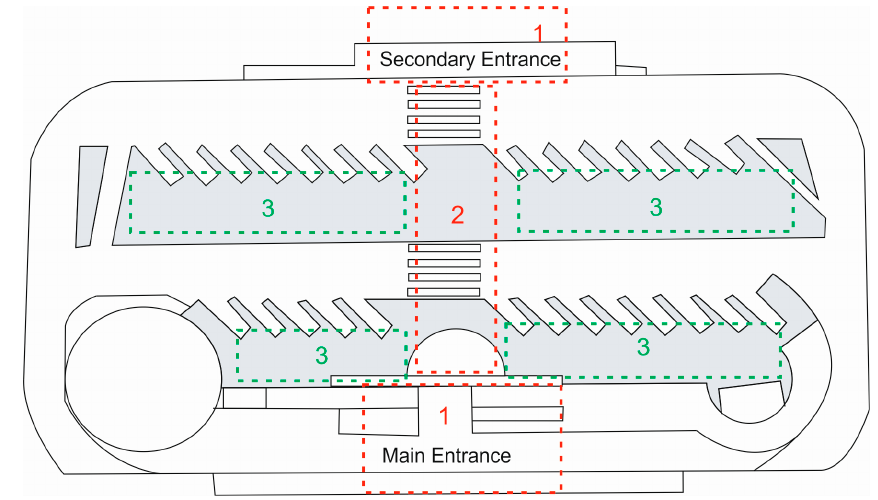
Figure 6. Schematic view of abstraction zones in a real scenario.